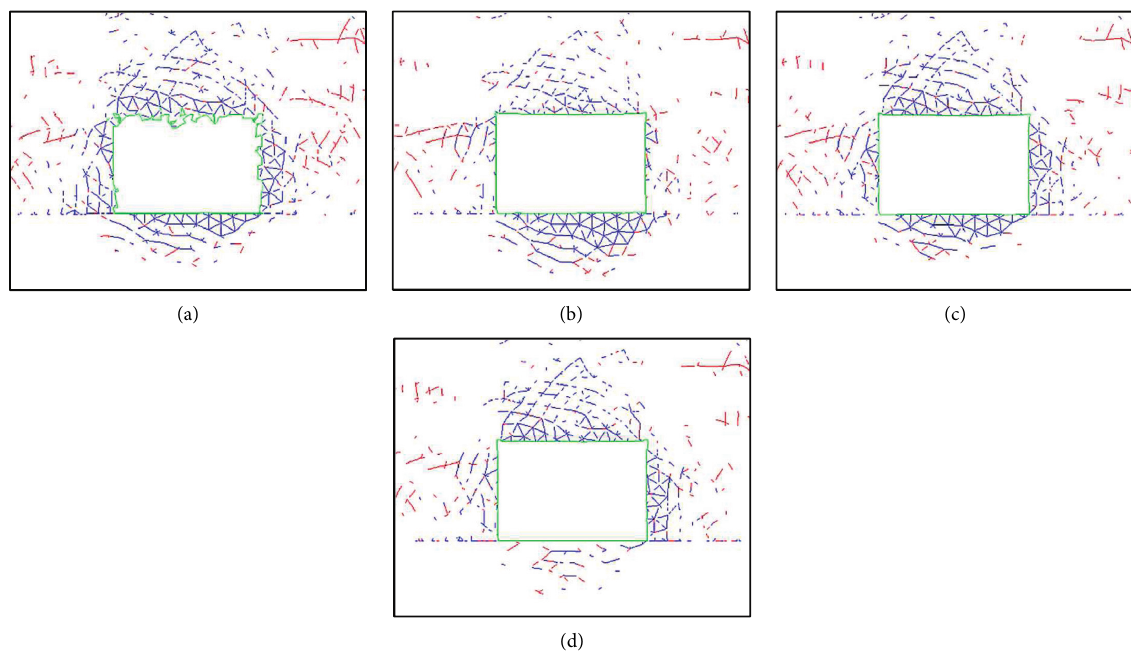
Figure 15: Crack distribution of roadway with different support schemes (red is the shear crack, blue is the tensile crack). (a) Scheme 1. (b) Scheme 2. (c) Scheme 3. (d) Scheme